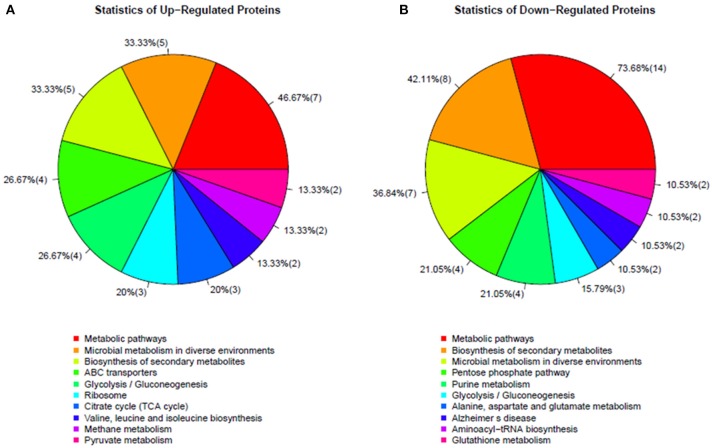
KEGG pathways enrichments in altered proteins in mutant strain Δrex. (A) Up-regulated proteins and (B) Down-regulated proteins.